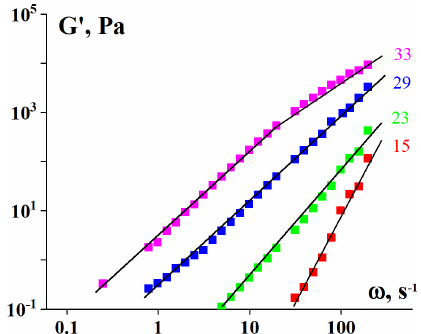
Figure 6: Frequency dependencies of the storage modulus for PSu solutions of different concentrations. Figures next to the curves show the concentration of the polymer in